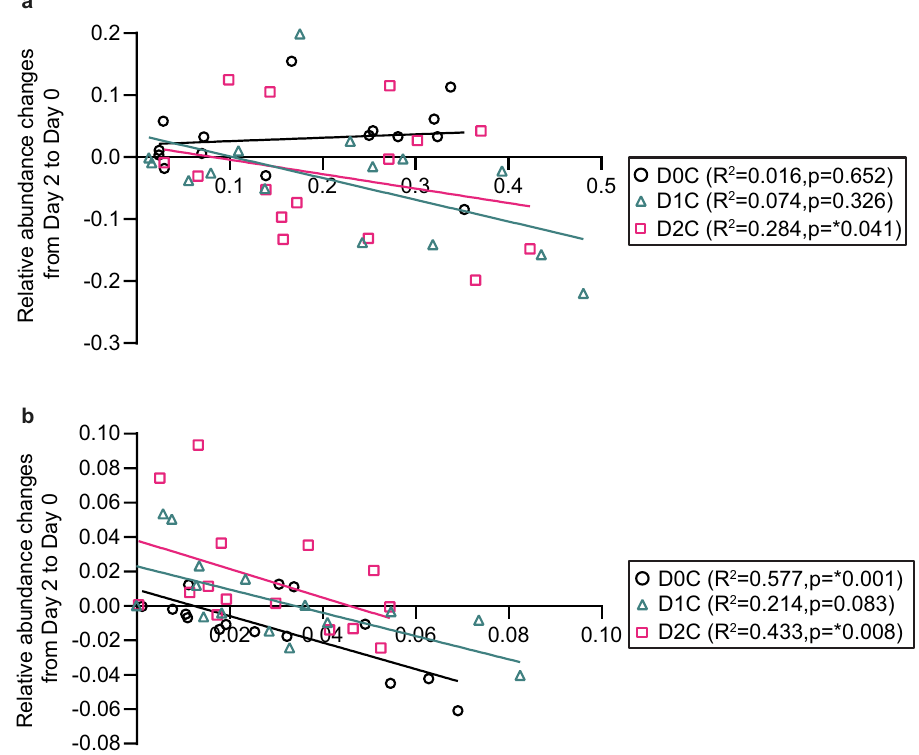
Figure 6. Changes in relative abundances of ( a ) Bacteroides and ( b ) Bifidobacterium in relation to baseline relative abundance for the three doses. Simple linear regression was applied and R 2 and p values were described for the group that had *p < 0.05. The relative abundance of bacteria at Day 0 and relative abundance changes were represented at X and Y axes, respectively. The colours represent the respective spices intervention session. D0C = Meal with no spices intervention, D1C = Meal with low (6 g) mixed spices intervention, D2C = Meal with high (12 g) mixed spices intervention. No of samples (each intervention) was